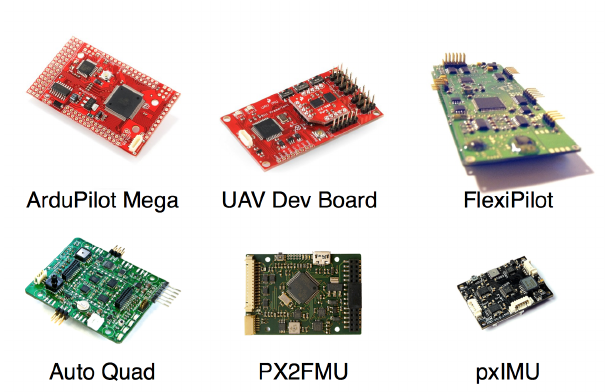
Figure 7: Autopilots using MAVLink as protocol: ArduPilot Mega, UAV Dev Board, FlexiPilot, AutoQuad, PX2FMU, IMU, SLUGS autopilot (not